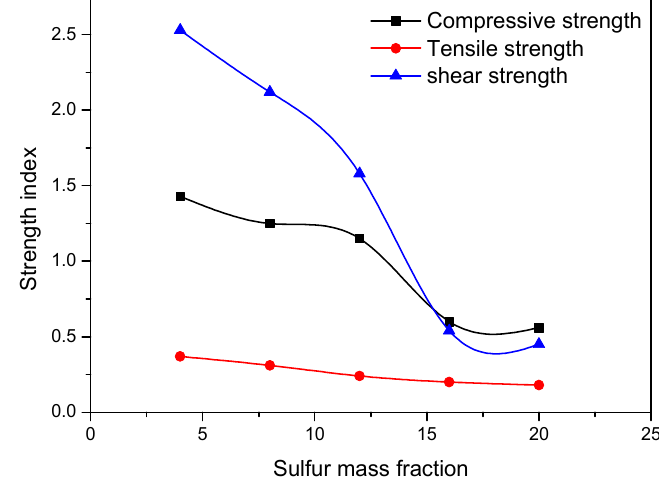
Figure 8. Strength index curve [35].